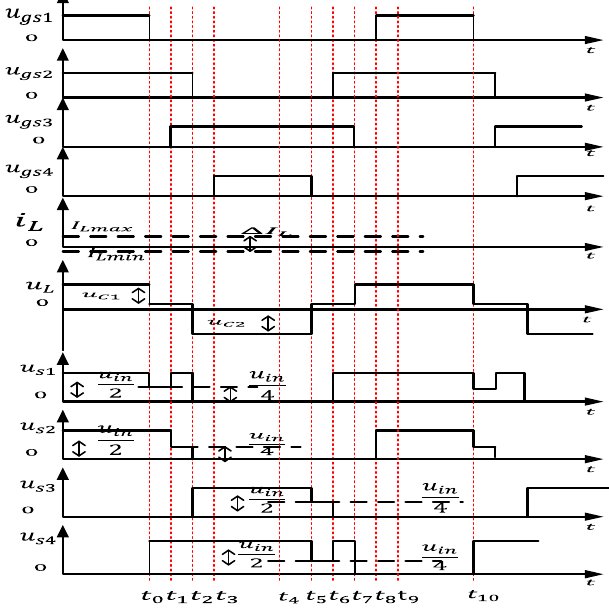
Figure 7. Main driving waveforms under state II.